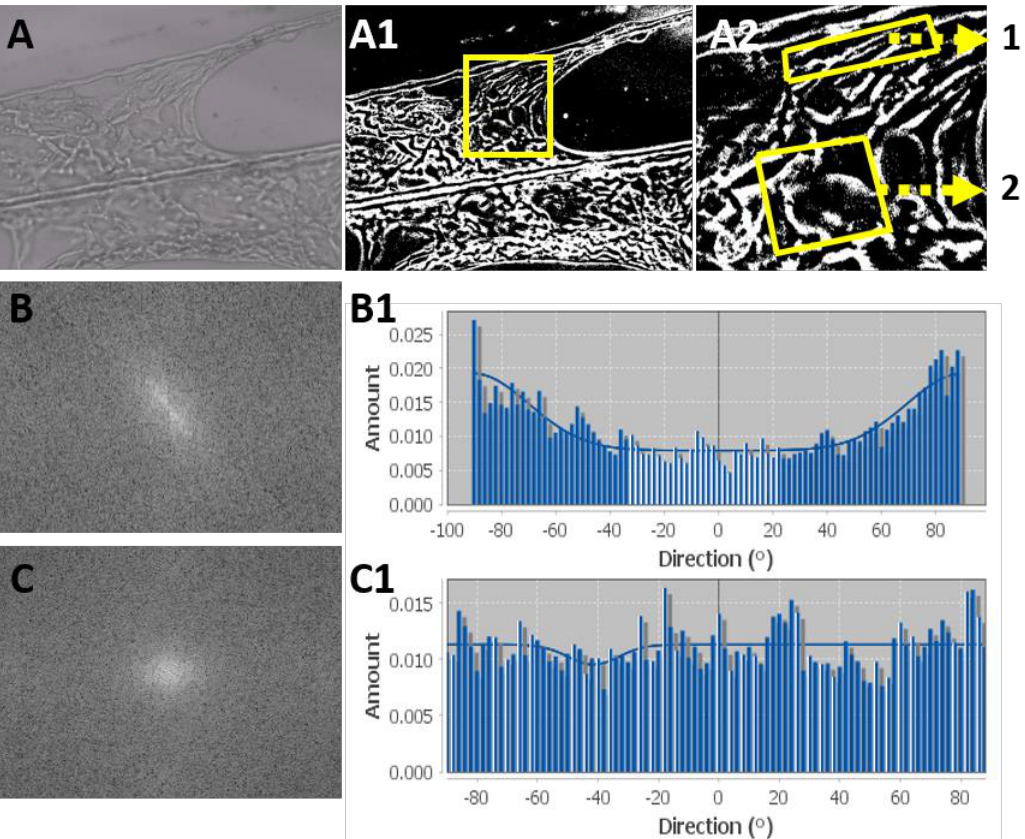
Figure 3. Cellular directional arrangement resembling tissue-like structures in biocomposites: cell orientation was analyzed using binary analysis of the light microscopy images (magnification ×200, A ). ( A1 ) transformation of the image to binary. ( A2 ) Magnification of the area marked in A1, showing two different ranges of interest (ROIs): 1, cells next to a fiber; 2, cells growing in tissue like structure between fibers. The ROIs were processed with a fast Fourier transform (FFT) filter and analyzed for directionality. FFT resulting image and histogram of the directionality analysis for ROI1 ( B and B1 ) and ROI2 ( C and C1 ).